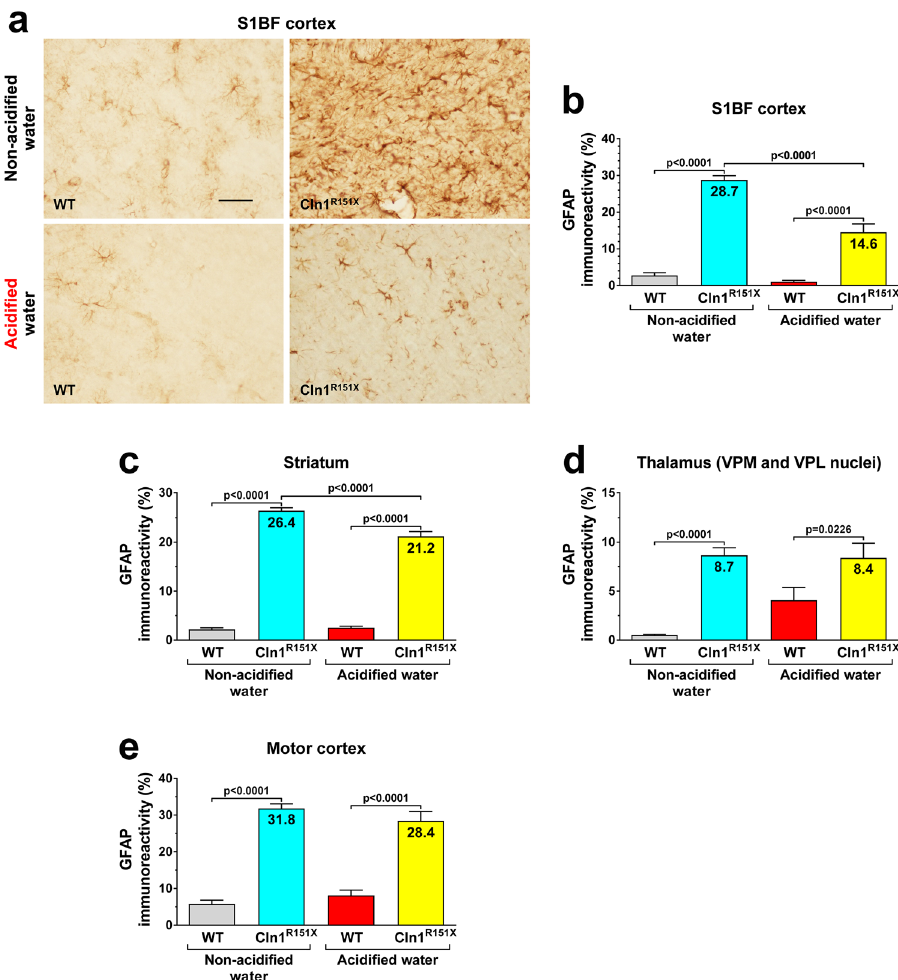
Figure 3. Acidified drinking water reduces astrocytosis in the striatum and somatosensory barrelfield cortex of Cln1 R151X mice. A group of Cln1 R151X and wild-type (WT) male mice received acidified drinking water from weaning (21 days of age) and were compared to male mice that always had non-acidified drinking water. At 6 months of age, astrocytic activation was assessed by immunostaining for the glial fibrillary acidic protein (GFAP) that forms intermediate filaments. Quantitative image analysis was performed in two sensory area, the somatosensory barrel field (S1BF) cortex and the ventral posteromedial (VPM)/ventral posterolateral (VPL) nuclei of the thalamus, and in two regions responsible for motor control, the motor cortex and striatum. ( a , b ) S1BF cortex. ( c ) Striatum. ( d ) Thalamus. ( e ) Motor cortex. The graphs show percent area of GFAP immunoreactivity. Columns and bars represent mean ± SEM (28–120 fields from 3–6 mice in each experimental group). Two-way ANOVA analysis showed a significant interaction between the two factors, genotype and type of drinking water, in the S1BF cortex and striatum (p < 0.0001). Only the genotype had a significant effect in the thalamus and motor cortex (p < 0.0001). In two-way ANOVA, Tukey’s post-test was used to calculate statistical significance in multiple comparisons. The size of the scale bar in the image is 50